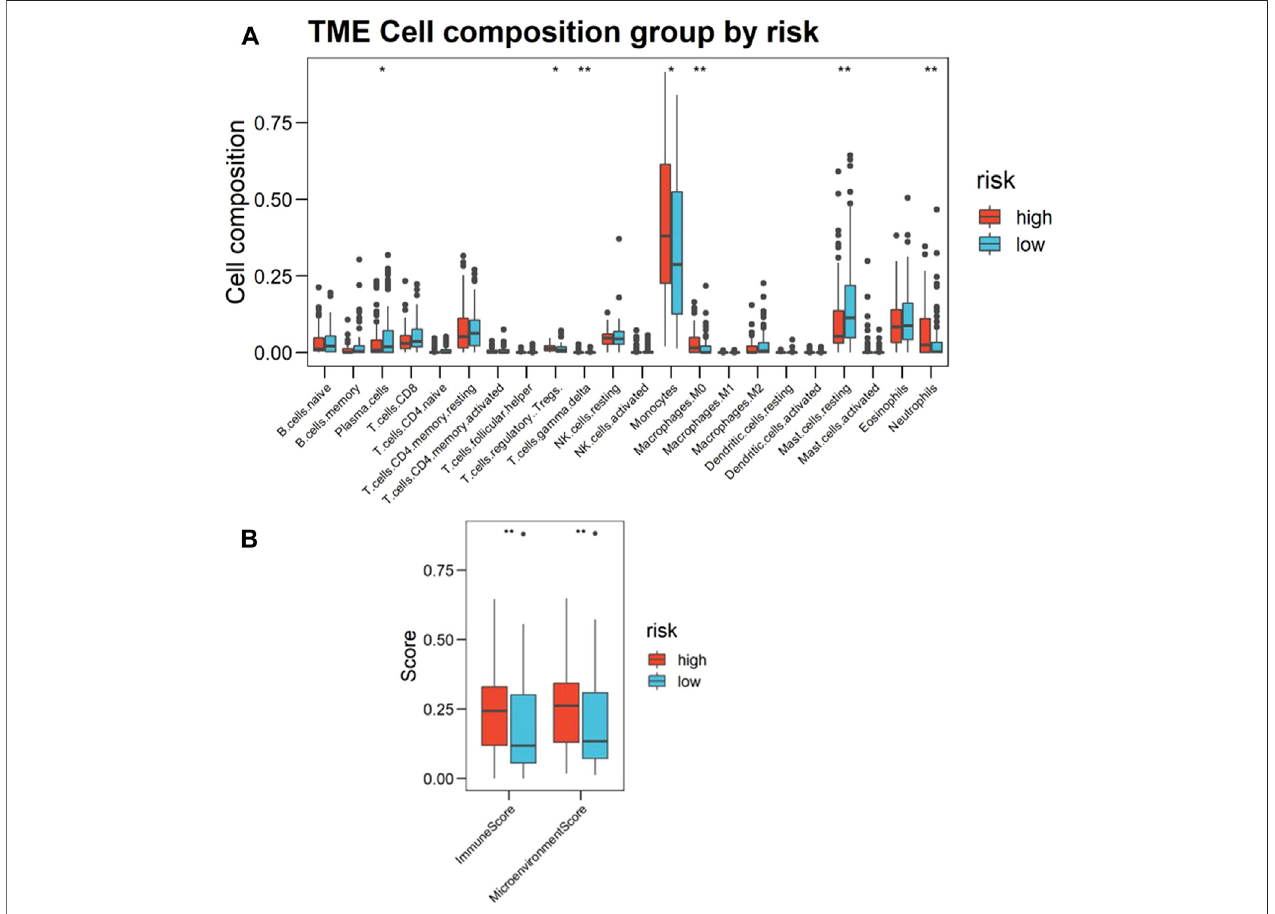
FIGURE 6 | Landscape of immune in fi ltration in the bone marrow (BM) of acute myeloid leukemia (AML) patients, as estimated from gene-expression data (Cohort 1, BM samples n (cid:1) 216) using CIBERSORT. (A) Boxplots visualizing signi fi cantly different immune cell in fi ltrations between high- and low-risk patients. The p -values calculated from Wilcoxon test are shown: * p -values < 0.05; ** p -values < 0.01; *** p -values < 0.001. (B) Immune Score and Microenvironment Score between high- and low-risk patients scoring by xCell based on estimated immune cell proportion. Higher hypoxia risk is associated with higher Immune Score and Microenvironment Score.